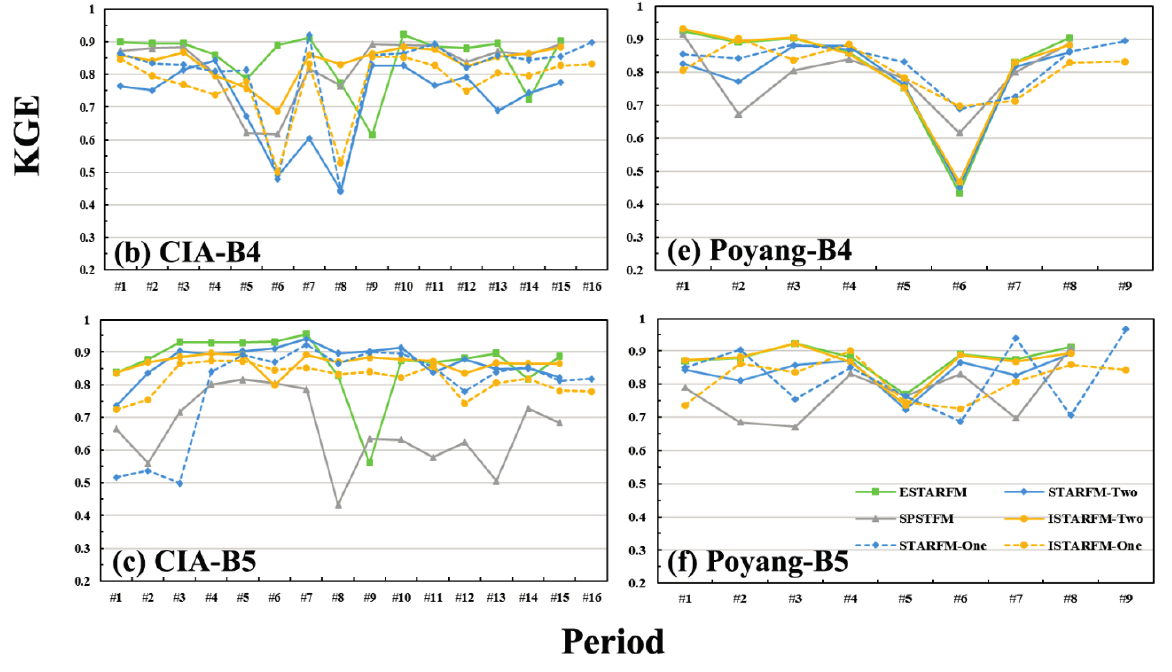
Figure 11. KGE values calculated for each model for the three selected bands at ( a – c ) the CIA and ( d – f ) Poyang Lake